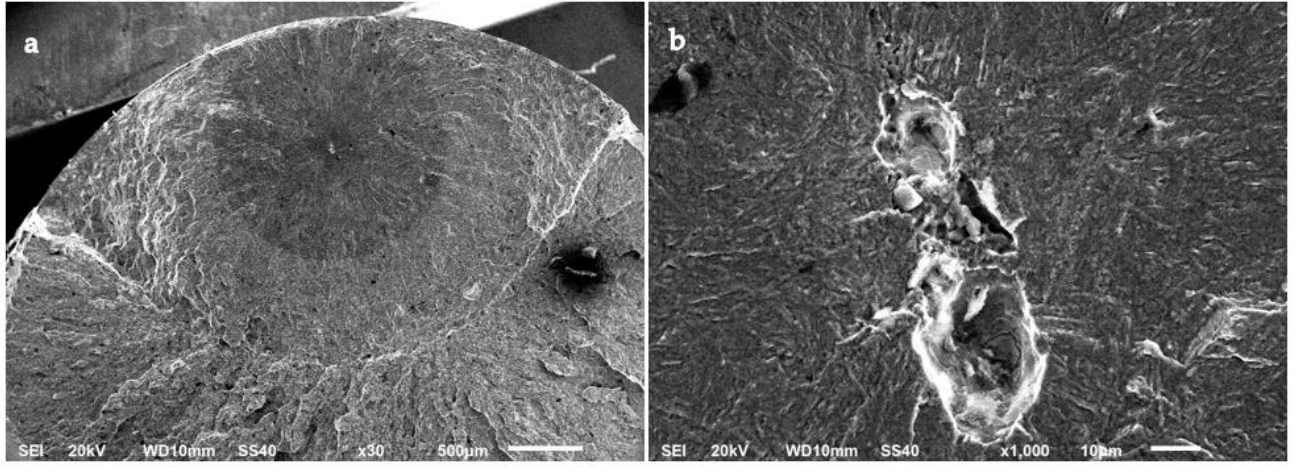
Figure 13. Internal crack initiation and fish-eye region of an A-type steel specimen tested in air to a maximum stress of 890 MPa (62% YS) for 8,370,000 cycles at ( a ) ×30 and ( b ) ×1000.